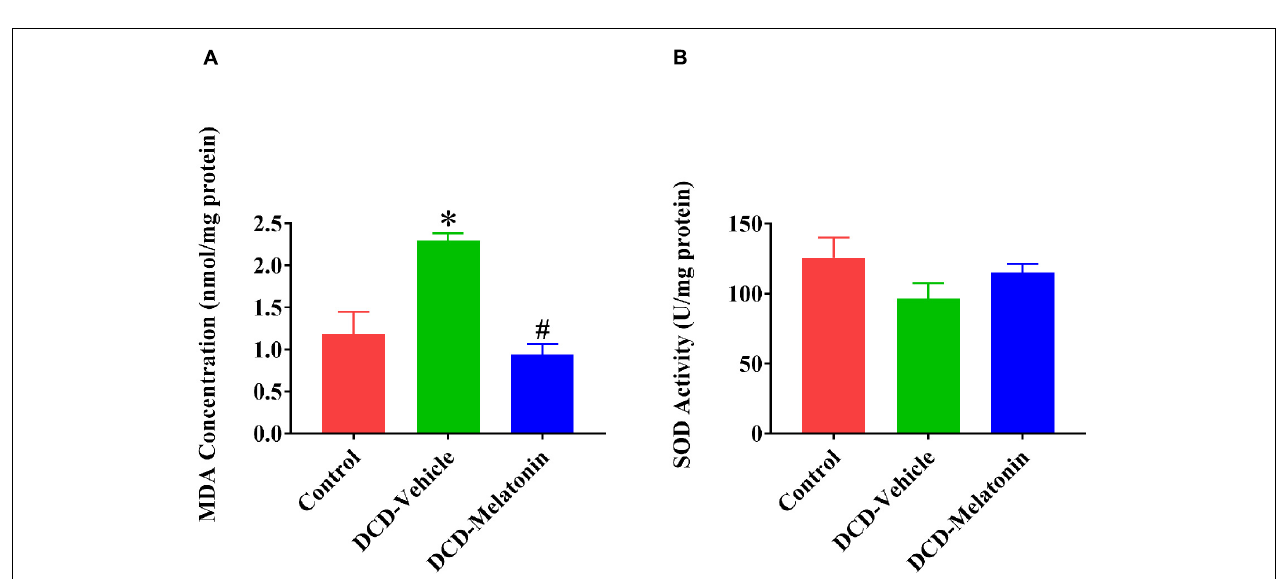
FIGURE 4 | Tissue content of MDA and SOD activity in the DCD heart preserved with EVHP. (A) Tissue content of MDA; and (B) SOD activity. Data represent mean ± standard error of the mean. n = 5 for each group. DCD, donation after circulatory death; EVHP, ex vivo heart perfusion; MDA, malonaldehyde; and SOD, superoxide dismutase. ∗ p < 0.05 vs. control; # p < 0.05 vs. DCD-vehicle.